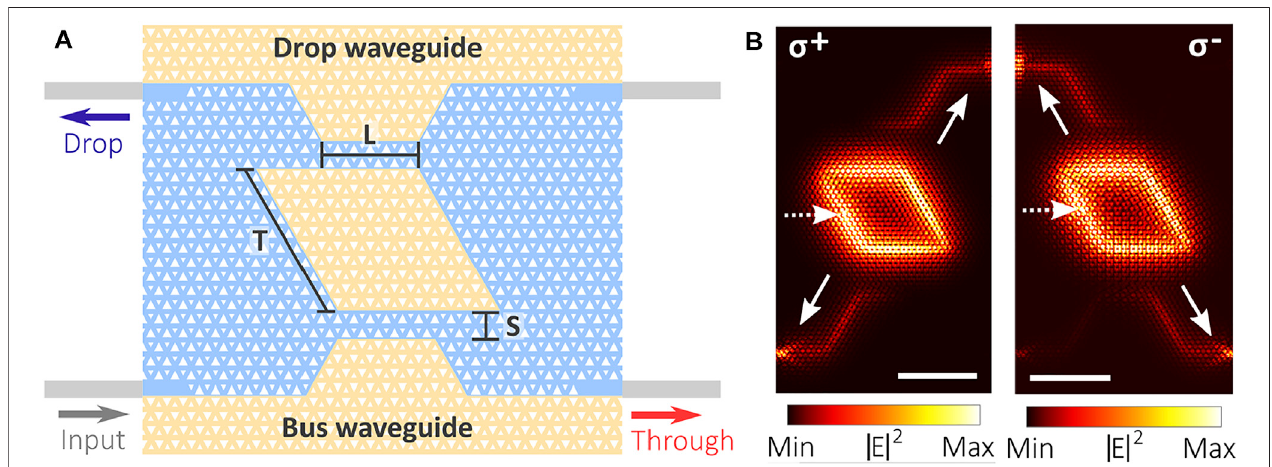
FIGURE 5 | (A) Schematic of a topological add-drop fi lter containing a rhombus-shaped ring resonator and a pair of access waveguides with the output ports marked by “ Through ” and “ Drop ” [80]. (B) Calculated electric fi eld intensity distribution when the device is excited by a dipole source with σ + and σ -